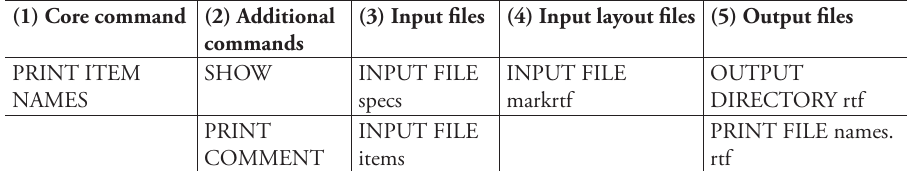
Figure 29. Directive fi le printnr for the output of taxon names used in a DELTA database. Th e numbers to the left of the directive fi le indicate diff erent classes of directives (see in Table Table 2. Classifi cation of commands used in the printnr directive fi le. Reference numbers used in Fig. 29 are given in the header of the table.